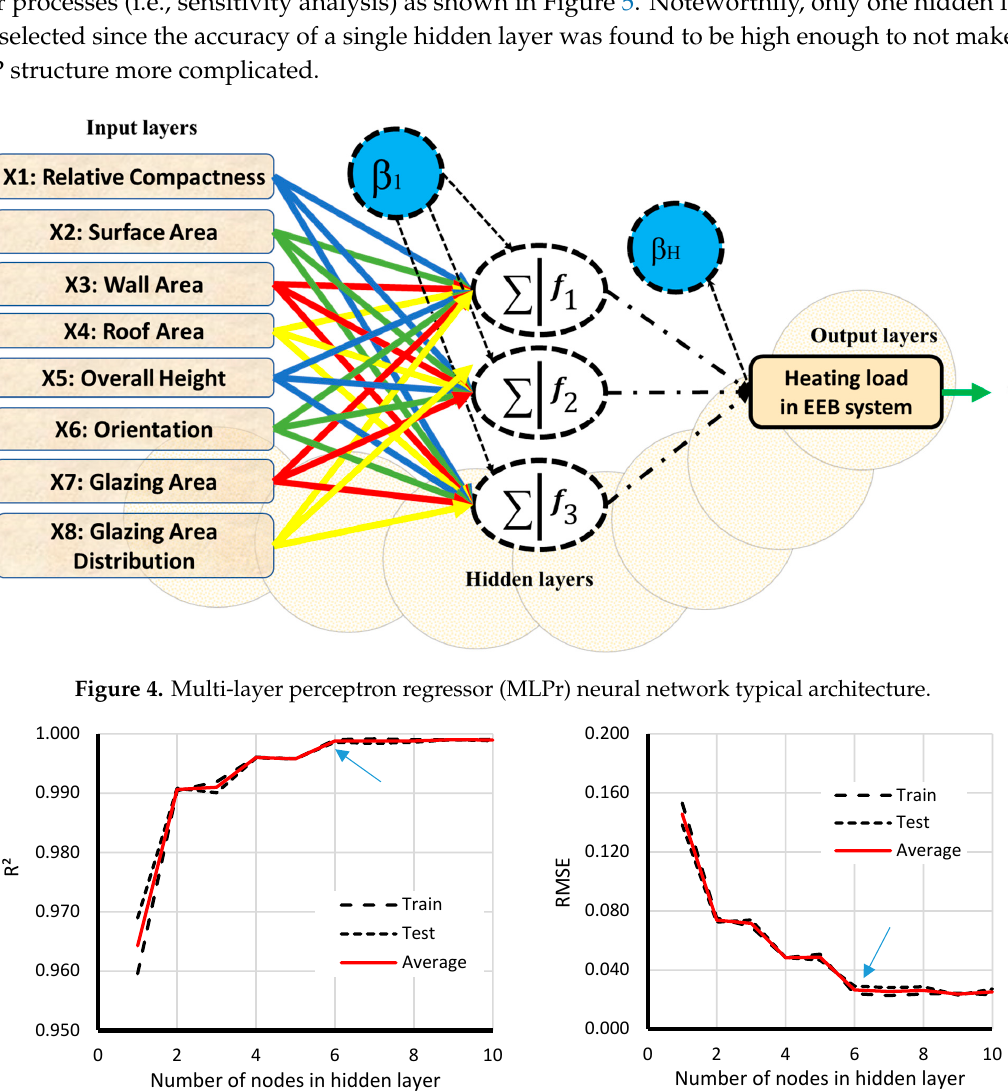
Figure 5. Sensitivity analysis based on number of neurons in a single hidden layer.